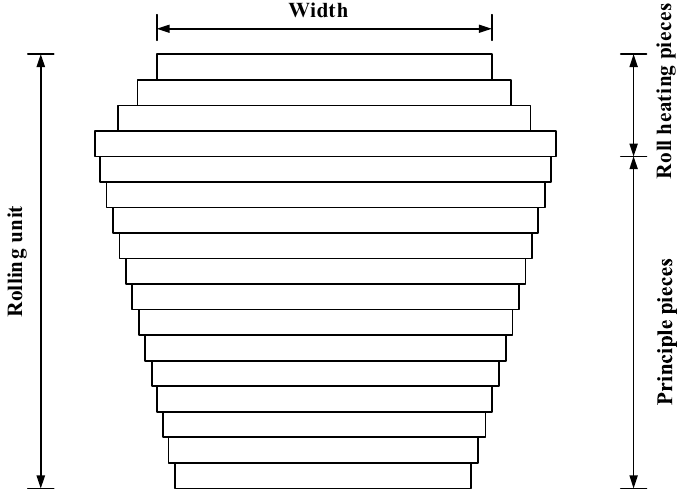
Figure 2. Schematic diagram of rolling unit.